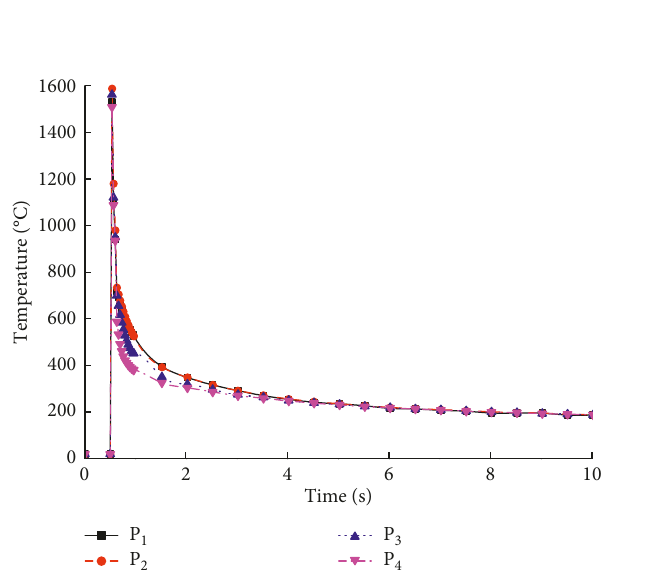
Figure 9: The temperature evolution at the trace points (2 nd welding condition).